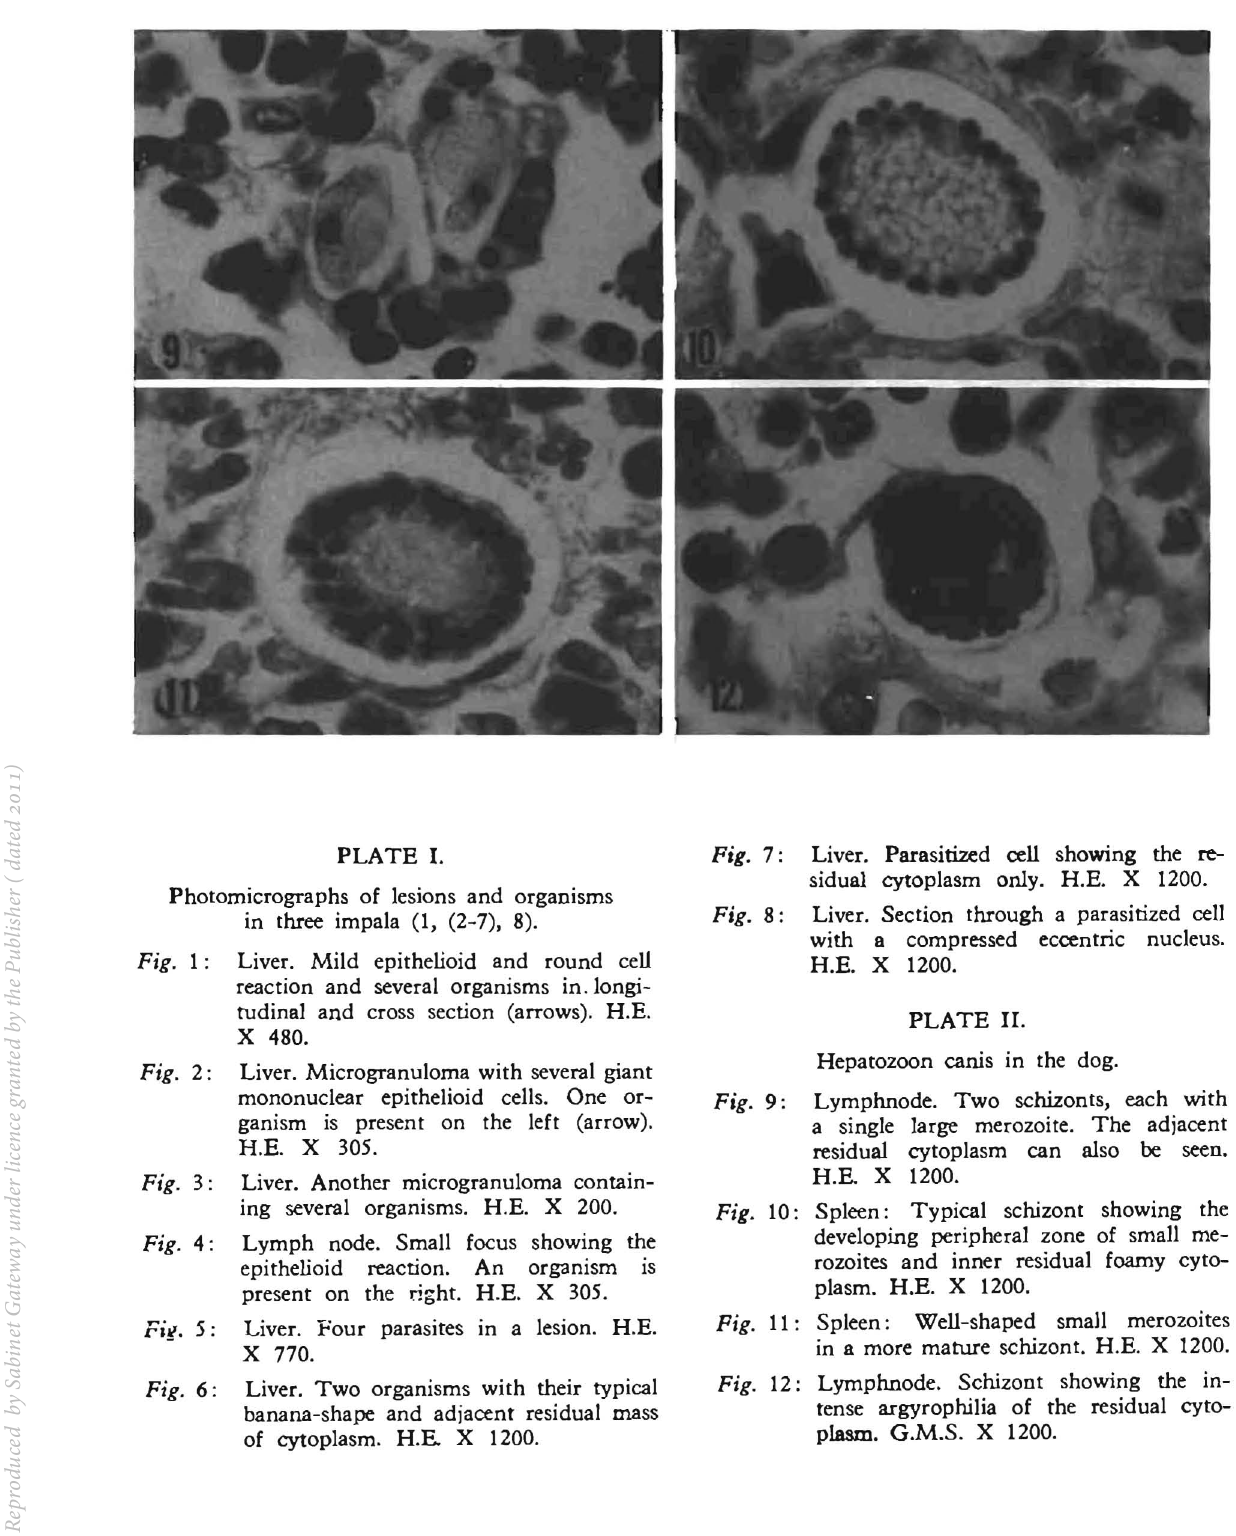
PLATE I. Photomicrographs of lesions and organisms in three impala (1, (2-7), 8). Fig. 1: Liver. Mild epithelioid and round ceU reaction and several organisms in. longi tudinal and cross section (arrows). H.E. X 480. Fig. 2: Liver. Microgranuloma with several giant mononuclear epithelioid cells. One or ganism is present on the left (arrow). H.E. X 305. Fig. 3: Liver. Another microgranuloma contain ing several organisms. H.E. X 200. Fig. 4: Lymph node. Small focus showing the epithelioid reaction. An organism is present on the right. H.E. X 305. Fig. 5: Liver. Four parasites in a lesion. H.E. X 770. Fig. 6: Liver. Two organisms with their typical banana-shape and adjacent residual mass of cytoplasm. H.E. X 1200.